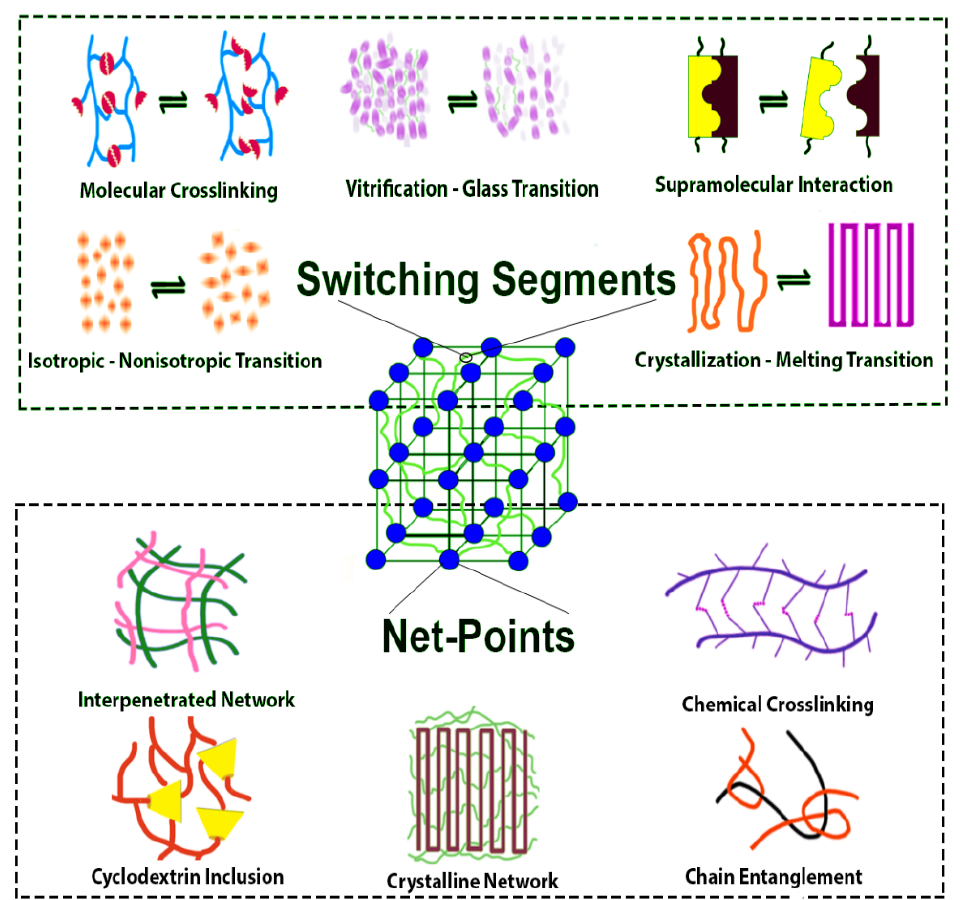
Figure 2. The overall schematic of the molecular architecture for SMPs consisting of switching segments and net-points.